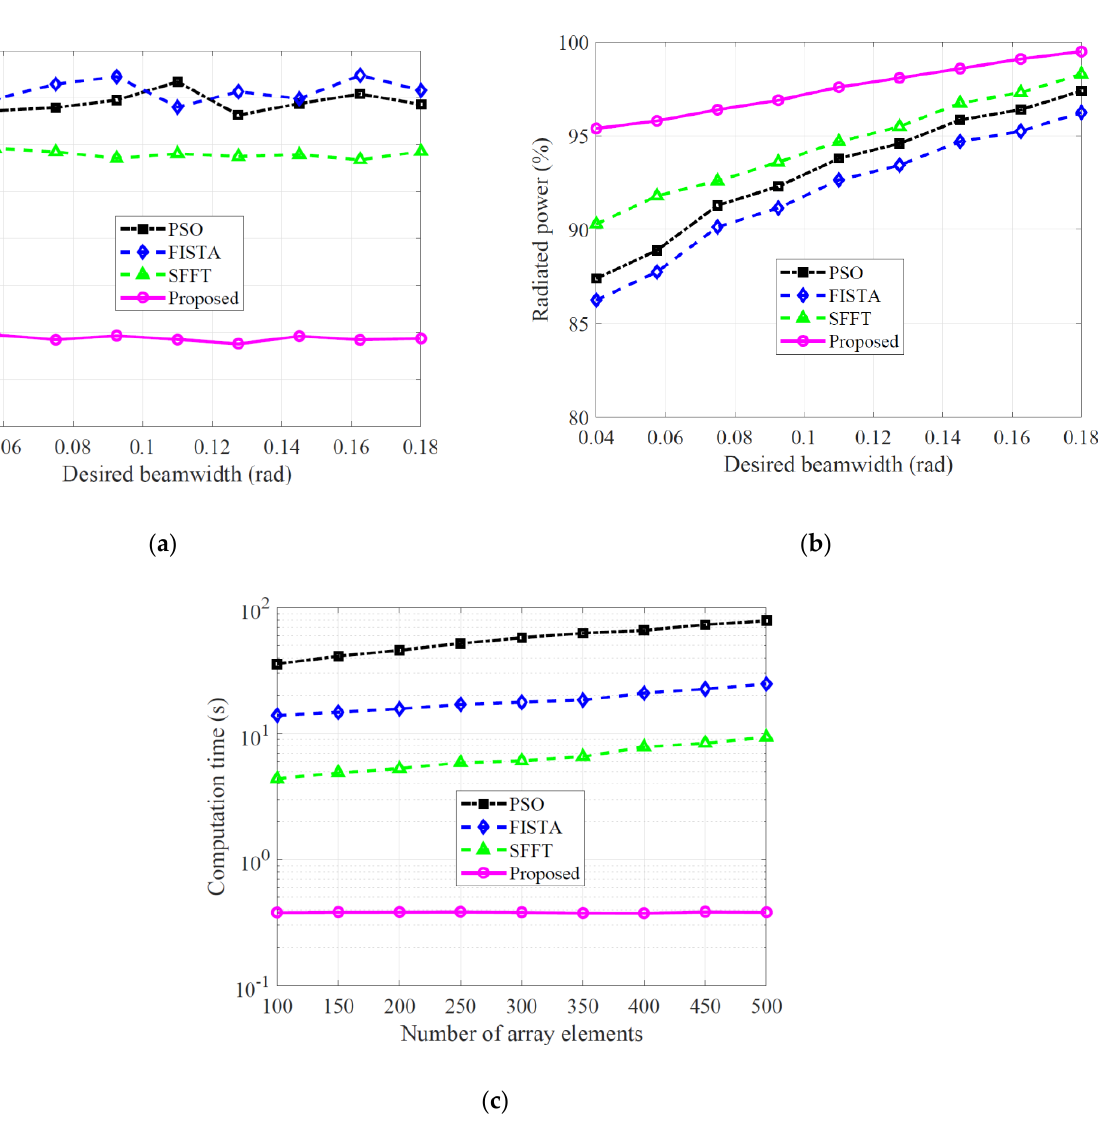
Figure 4. ( a ) HPBW error calculated as the absolute value of the difference between synthesized and desired HPBWs; ( b ) Percentage of power radiated by each APS technique in the mainlobe region; ( c ) Average computation times (on a semilogarithmic scale) required to synthesize desired AF with beamwidth τ M = 0.07 (rad) versus the number of array elements for each APS